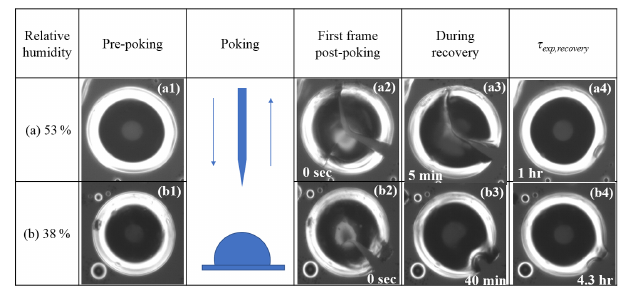
Figure 4. Optical images of diesel fuel SOA particles during poke- and-flow experiments. In these experiments the SOA particles were poked at 0%RH and then exposed to RH values of 53% (a) and 38% (b) . The last column shows the particles after they have re- turned to a spherical cap